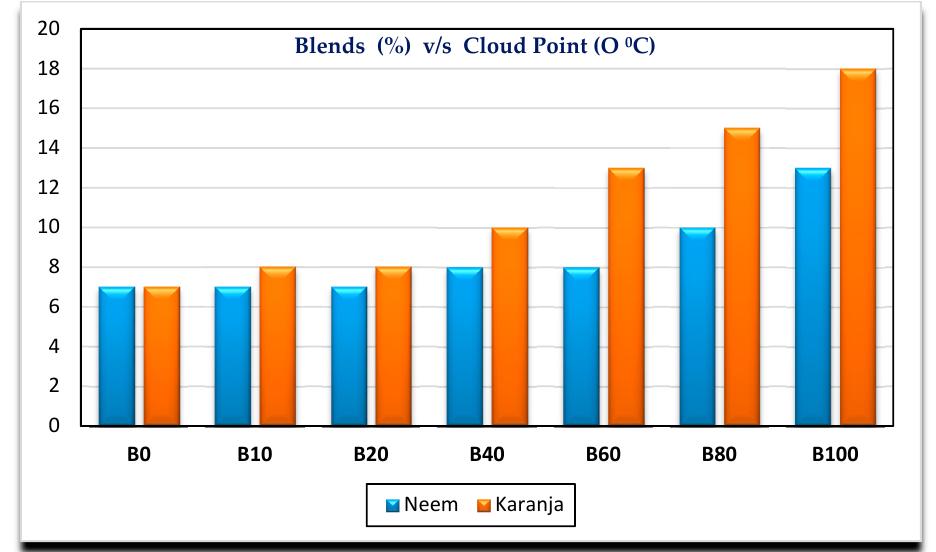
Figure 4. Variation of cloud point with biodiesel-diesel blends. Table 4. Fuel properties of Neem biodiesel-diesel blends by DT method.